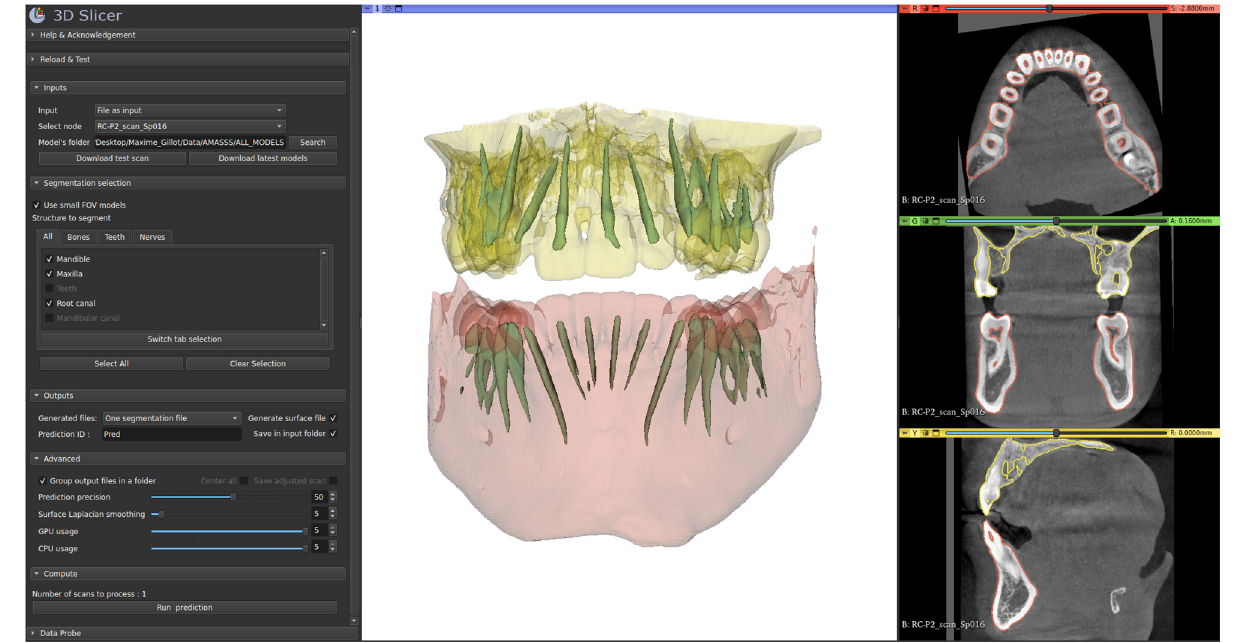
Fig 6. 3D Slicer module in development for AMASSS-CBCT. On the left, we can see the module with the different options/parameters. On the right, the visualisation of the segmentation applied on one small field of view scan with the selected skull structures. The mandible in red, the maxilla in yellow and the root canals in